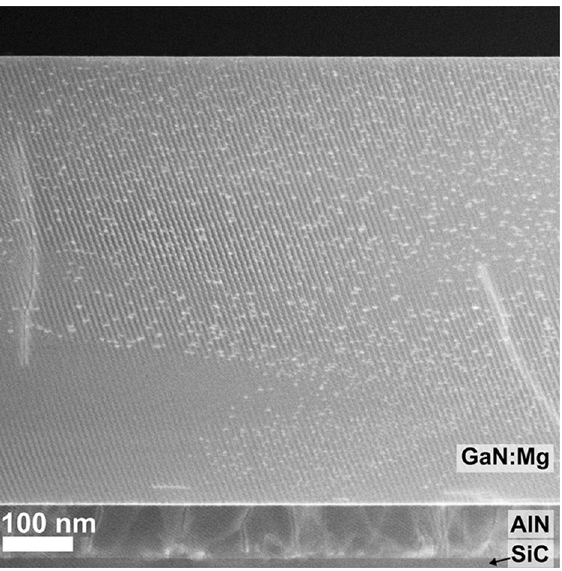
Figure 1. Cross-sectional ADF-STEM overview image of the sample structure: SiC-AlN-GaN:Mg with the substrate at the bottom. The apparent stripes originate from interference between the image pixels and the crystal